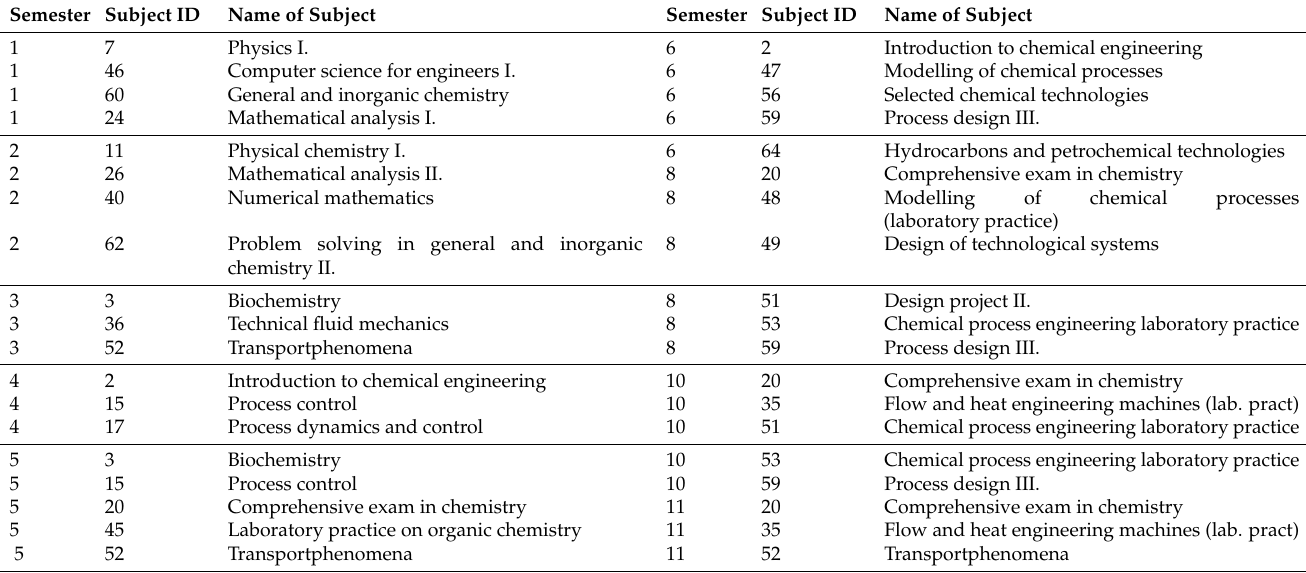
Table 4. Grouping of critical objects by their names according to the subject identifiers in Appendix